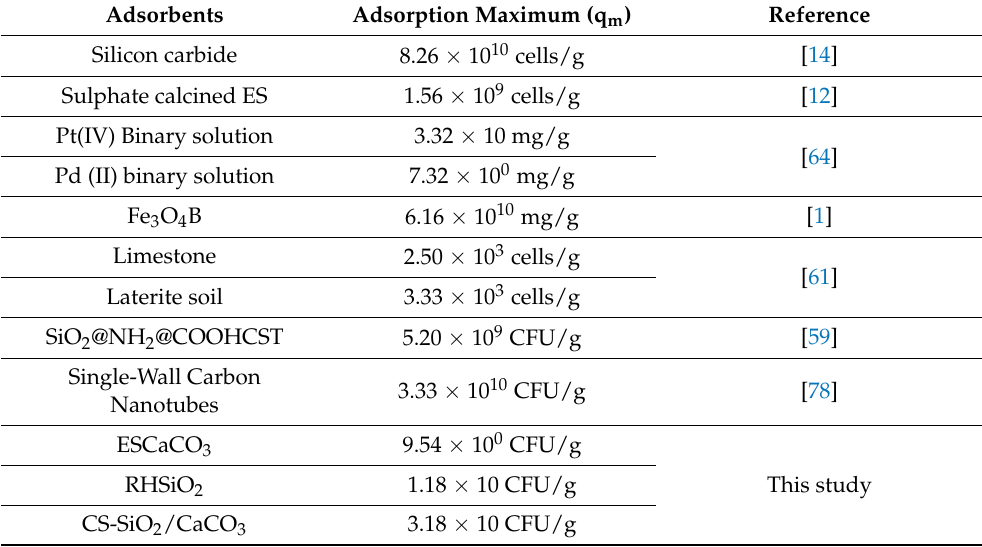
Table 2. Comparison of the maximum sorption capacity (q m ) of E. coli onto CS-SiO 2 /CaCO 3 , RHSiO 2 , ESCaCO 3 with those of other